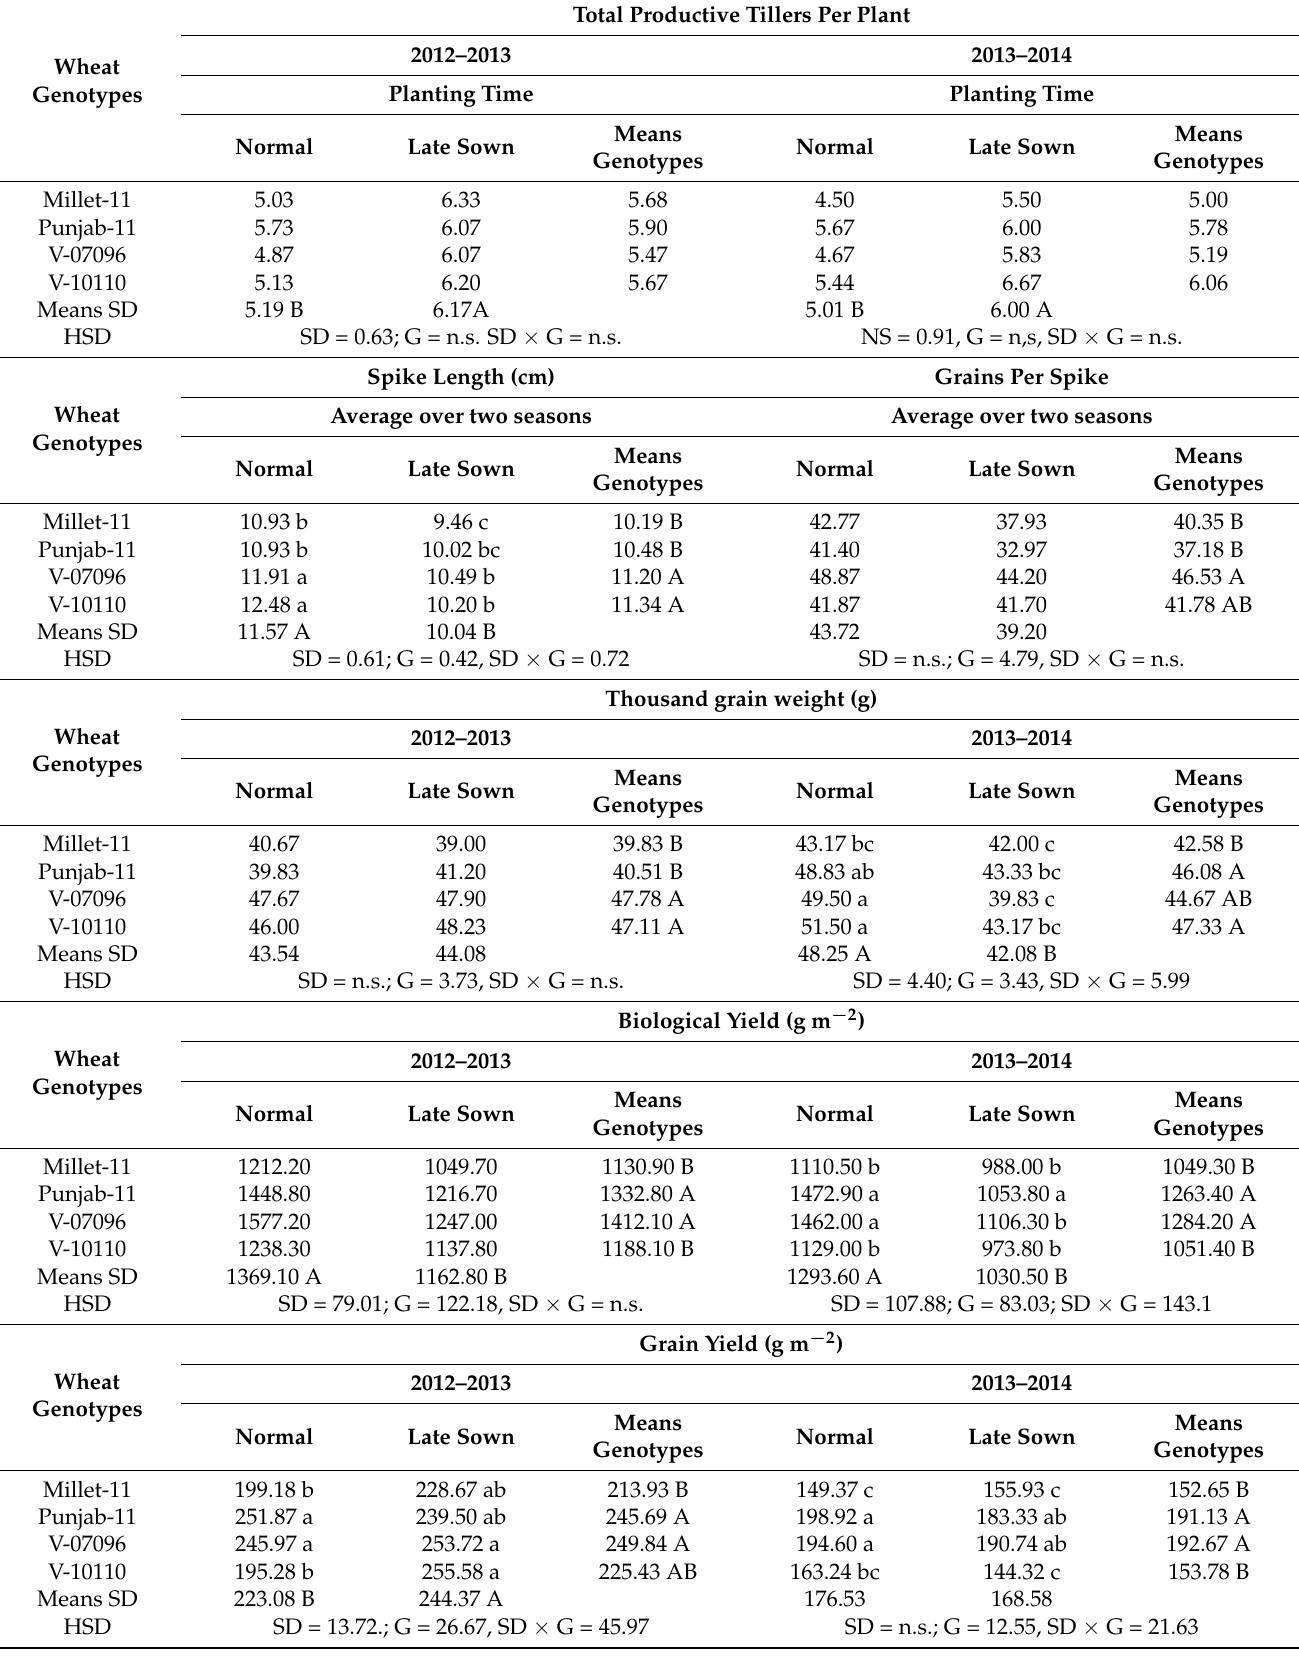
Table 2. Mean comparison for yield related traits in wheat genotypes under late sowing condition.